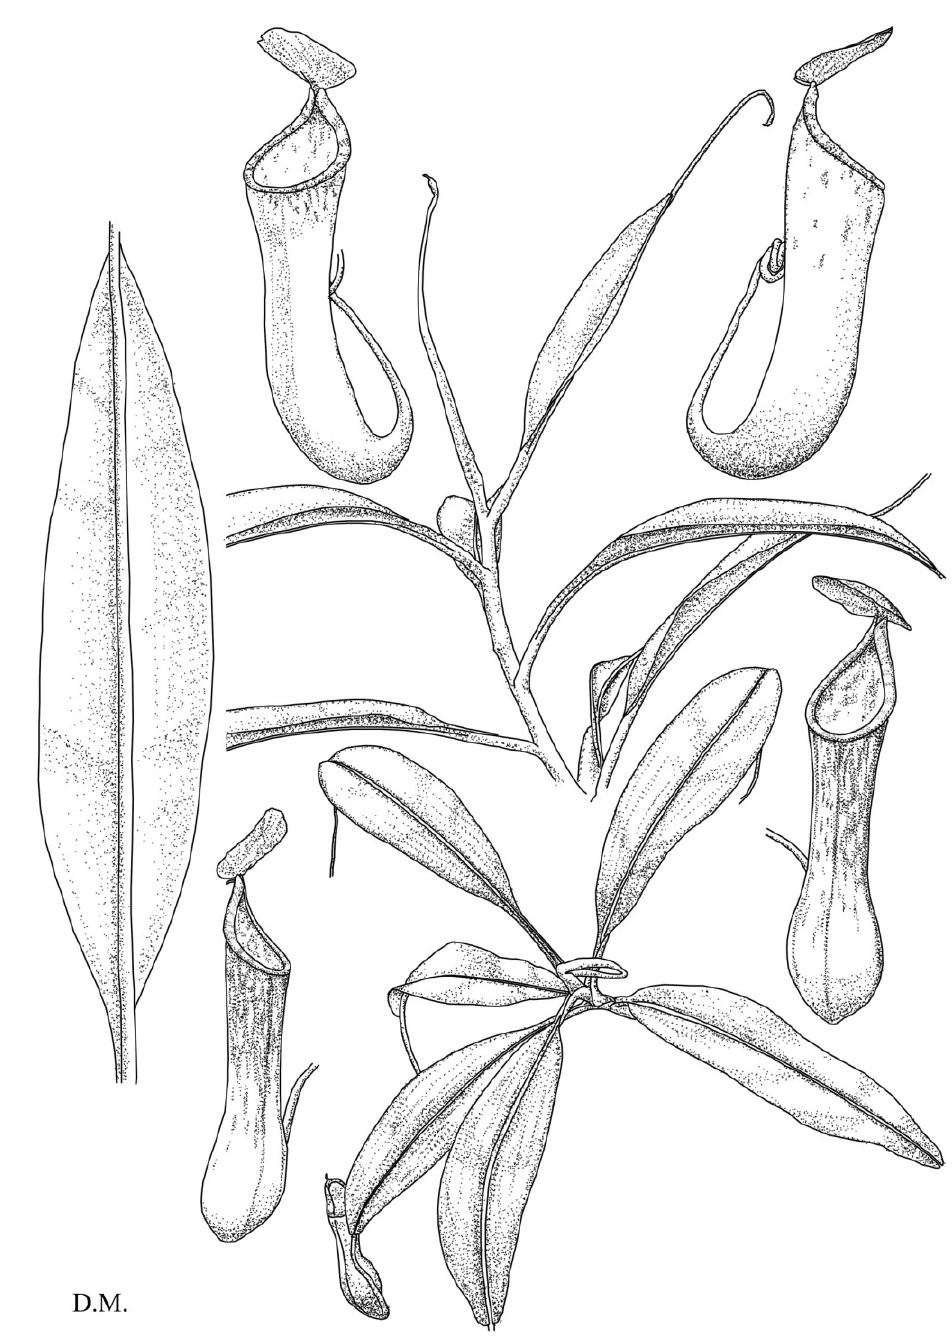
Figure 2. N. cornuta. Habit, showing the stem with upper pitchers ( top ). Top view of the rosette with lower pitchers ( bottom